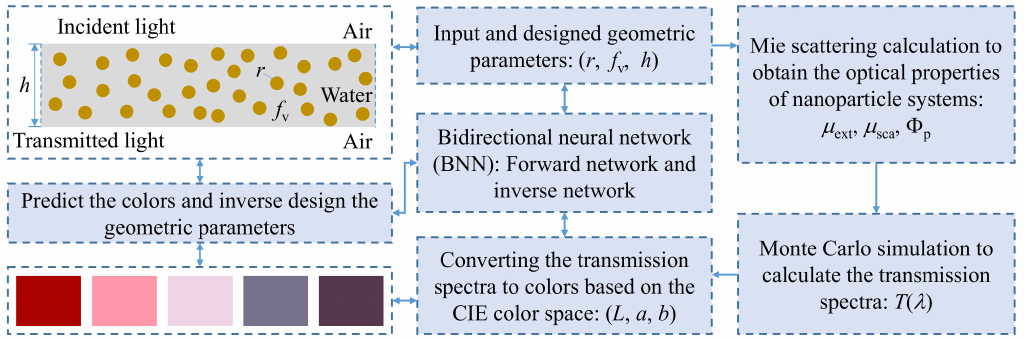
Figure 1. Schematic of the model and methods for the prediction and inverse design of structural colors of nanoparticle systems.